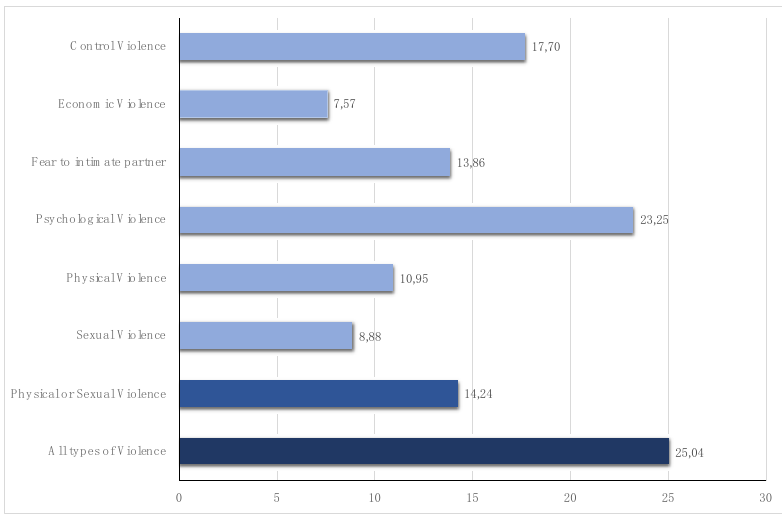
Figure 1. Incidence of different types of IVP against women in Spain. Source: VI Violence against Women Macro-survey-2019.